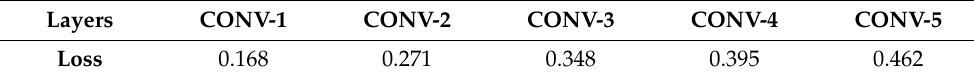
Table 4. MSE Loss at each convolutional Layer of Proposed Transfer Learning based DCNN Model on Figshare dataset. Table 2. Experimental Results of Proposed Transfer Learning based DCNN Model on Figshare dataset.